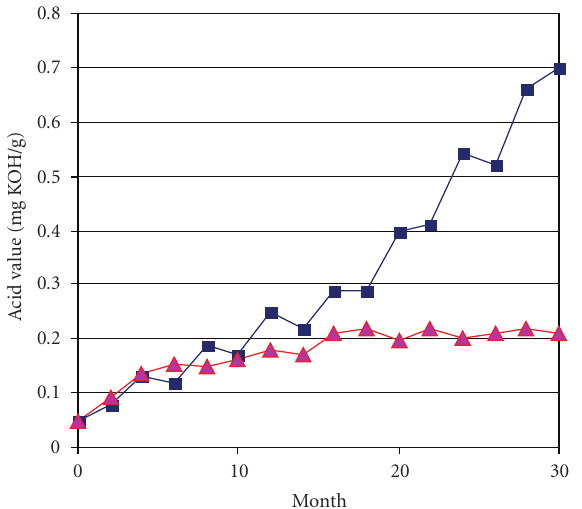
Figure 6: Variation in the acid value of corn oil biodiesel stored (cid:2) under normal oxygen atmosphere and (cid:3) under argon atmosphere.